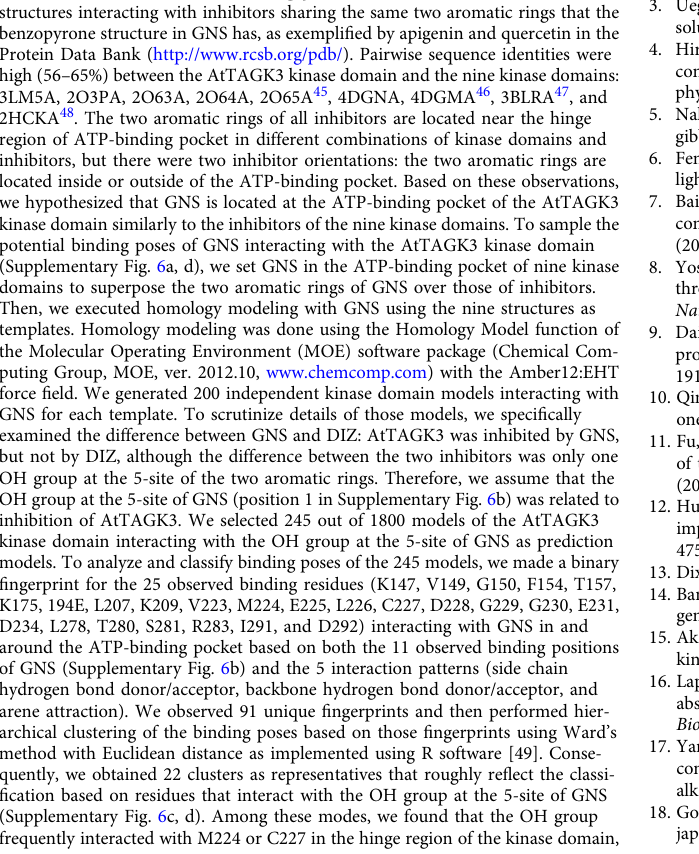
Prediction of AtTAGK3-GNS binding poses . We found nine kinase domain structures interacting with inhibitors sharing the same two aromatic rings that the benzopyrone structure in GNS has, as exempli fi ed by apigenin and quercetin in the Protein Data Bank (http://www.rcsb.org/pdb/). Pairwise sequence identities were high (56 – 65%) between the AtTAGK3 kinase domain and the nine kinase domains: 3LM5A, 2O3PA, 2O63A, 2O64A, 2O65A 45 , 4DGNA, 4DGMA 46 , 3BLRA 47 , and 2HCKA 48 . The two aromatic rings of all inhibitors are located near the hinge region of ATP-binding pocket in different combinations of kinase domains and inhibitors, but there were two inhibitor orientations: the two aromatic rings are located inside or outside of the ATP-binding pocket. Based on these observations, we hypothesized that GNS is located at the ATP-binding pocket of the AtTAGK3 kinase domain similarly to the inhibitors of the nine kinase domains. To sample the potential binding poses of GNS interacting with the AtTAGK3 kinase domain (Supplementary Fig. 6a, d), we set GNS in the ATP-binding pocket of nine kinase domains to superpose the two aromatic rings of GNS over those of inhibitors. Then, we executed homology modeling with GNS using the nine structures